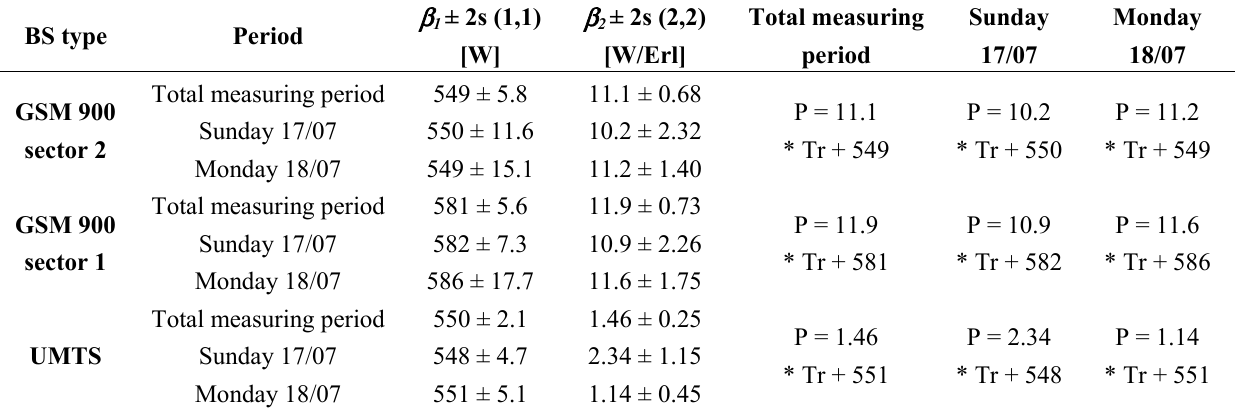
Table 7. Calculated regression coefficients with linear models for different BS technologies.